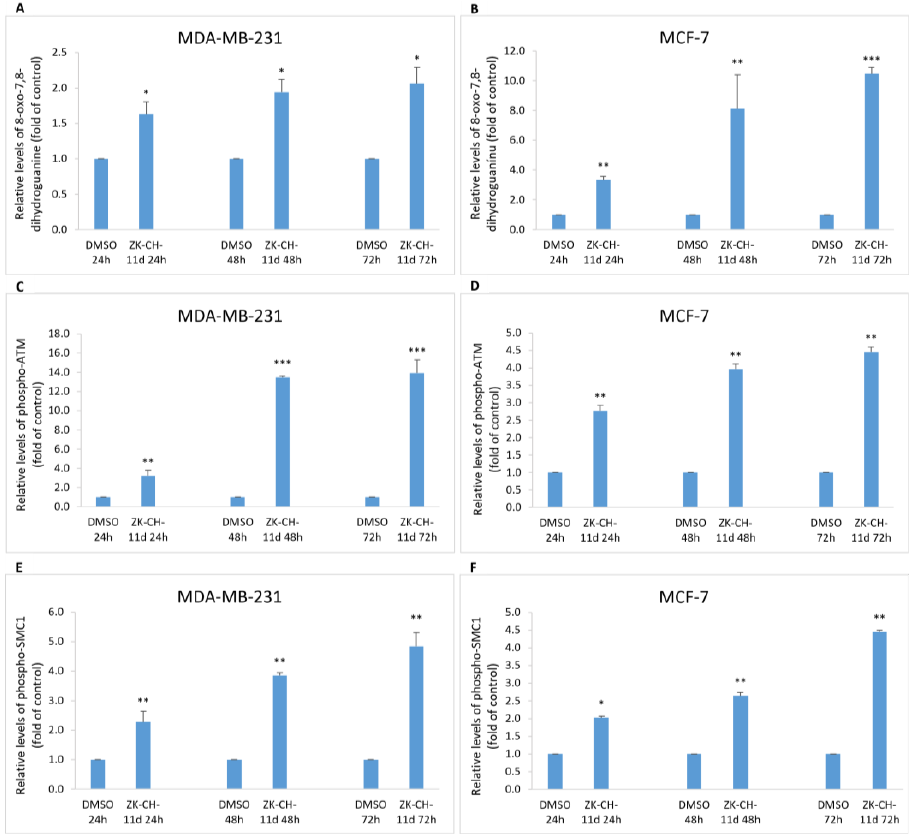
Figure 12. Analysis of DNA damage induced by chalcone ZK-CH-11d at a concentration of 40 μmol/L. Relative changes in 8-oxo-7,8-dihydroguanine levels ( A , B ), phospho-ATM ( C , D ) and phospho-SMC1 ( E , F ) protein levels in MDA-MB-231 and MCF—7 after 24, 48, and 72 h of chalcone treatment. The values are the mean of three independent experiments. Statistical significance: * p < 0.05, ** p < 0.01, *** p < 0.001 vs. vehicle (DMSO).